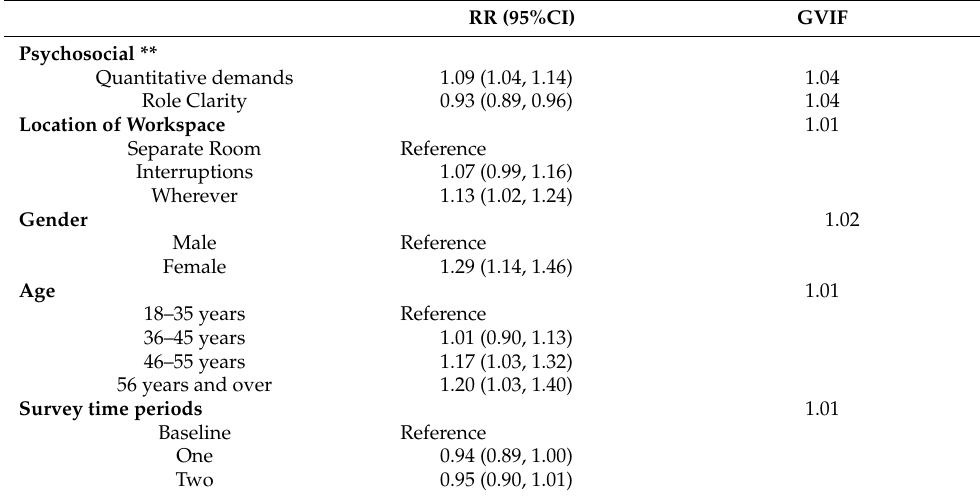
Table 4. Associations between musculoskeletal pain levels * and psychosocial factors and workspace. RR (95%CI) GVIF Psychosocial ** Quantitative